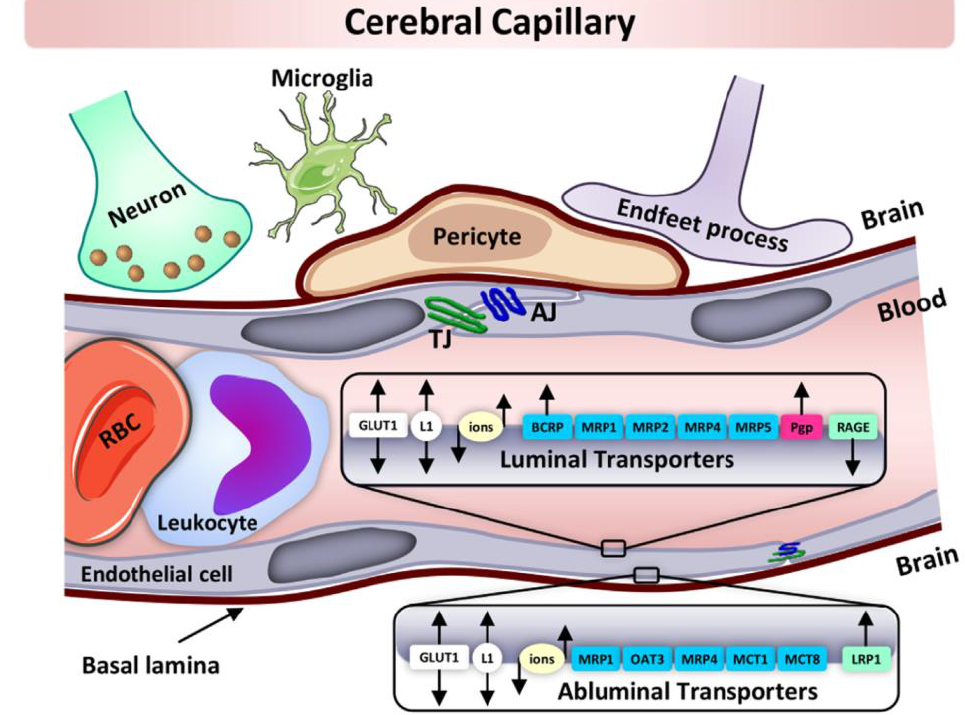
Figure 2. A detailed overview of the cellular constituents of the BBB. Reprinted with permission from Ref. [47]. Copyright 2021 Elsevier.